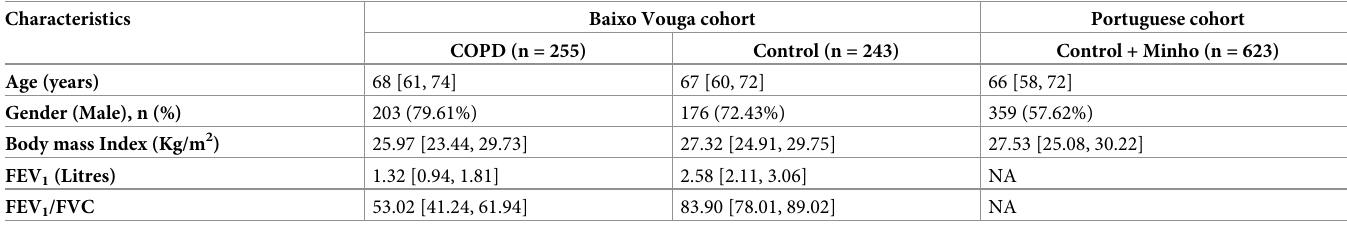
Table 1. Sociodemographic, anthropometric and clinical characteristics of participants.